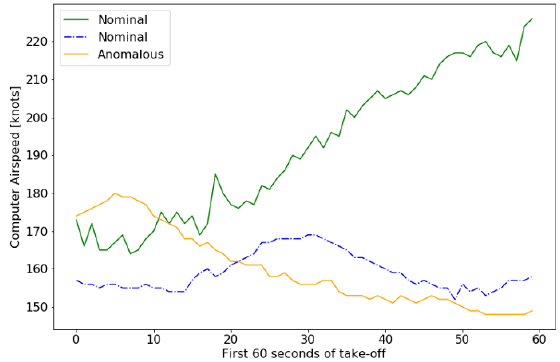
Figure 4. Computer airspeed during the first 60 s of take-off for three